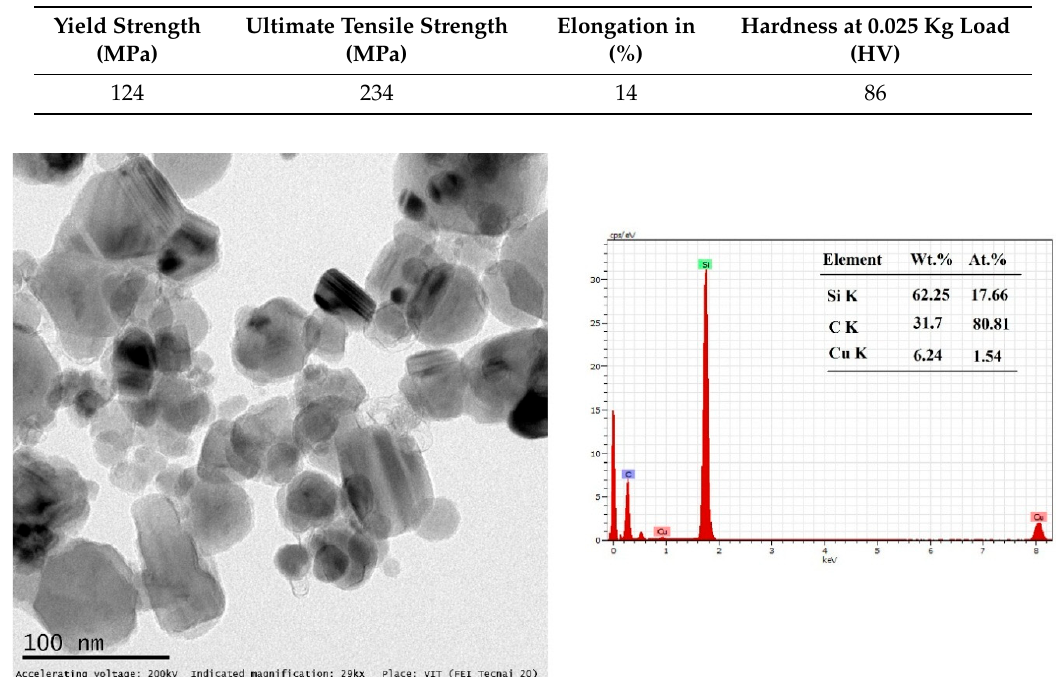
Table 2. Properties of the AZ31B magnesium alloy.